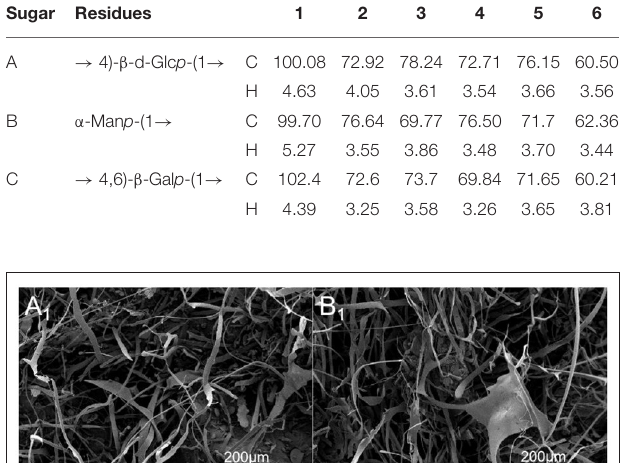
FIGURE 4 | TG, DTG, and DSC curves of